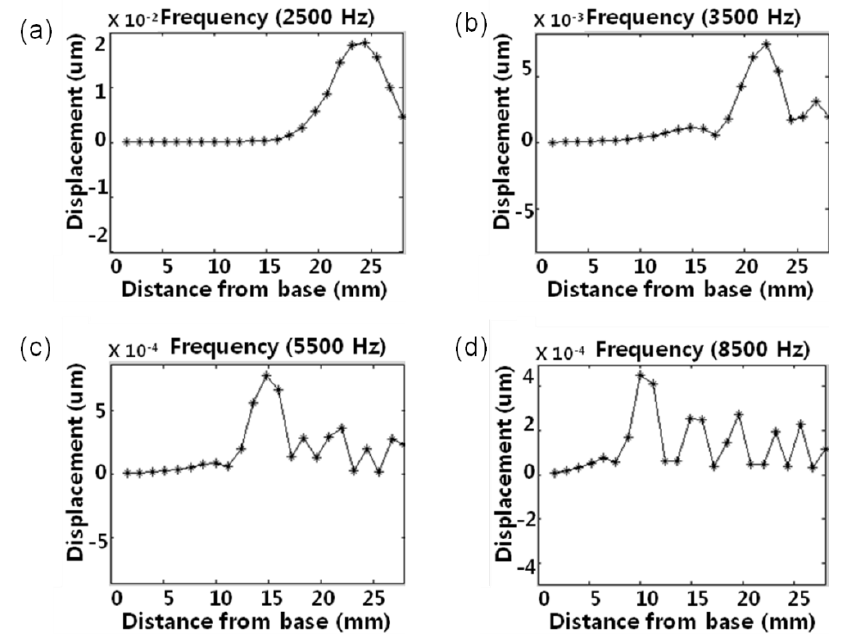
Figure 8. The local resonant response of the McPAS membrane with sound sources